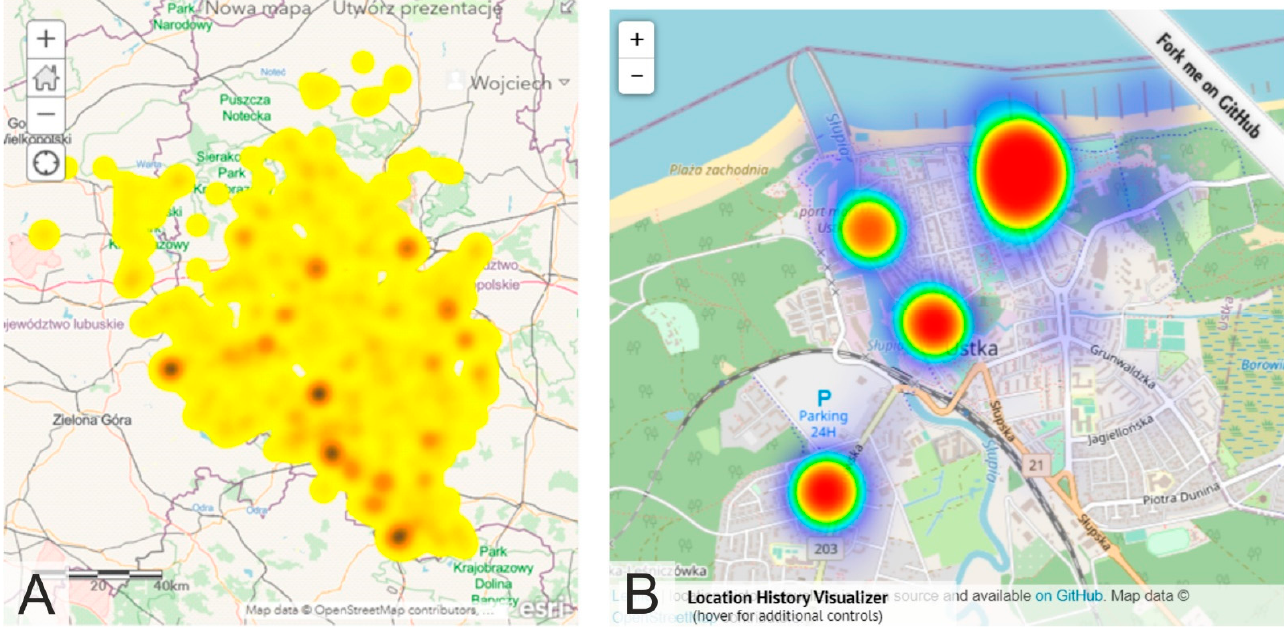
Figure 1. Selected examples of a heat maps with Open Street Map base maps (( A ) heat map prepared in ArcGIS Online [22], ( B ) Location History Visualizer [21]).